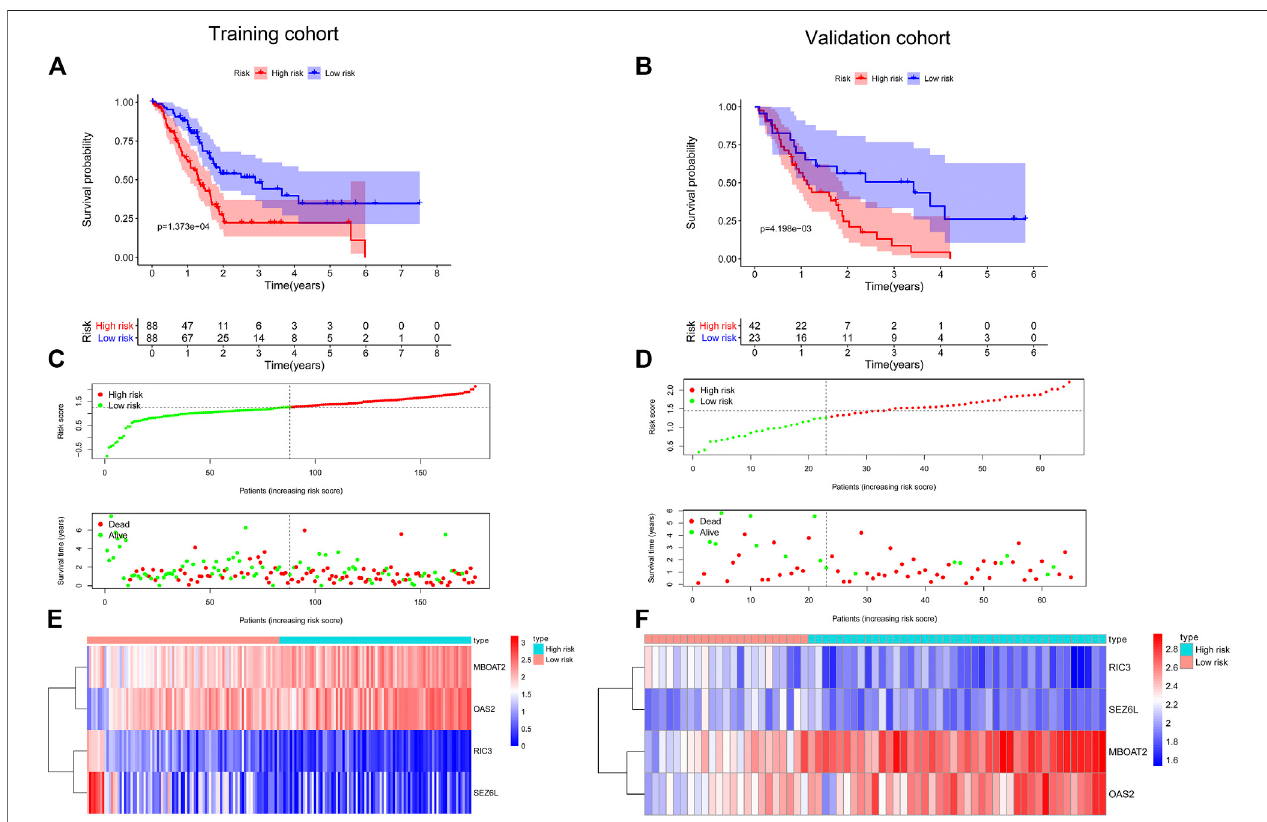
FIGURE6| EstablishmentandvalidationofaprognosticmodelforPC.Kaplan – Meiersurvivalcurvesshowedthatthehigh-riskgrouphadshorterOSthanthelow- risk group in the training cohort (A) and the validation cohort (B) . The distribution of the survival status and time in different risk groups by the scatter plots in the training cohort (C) andthevalidationcohort (D) .HeatmapofthefourscreenedDNAmethylation-drivengeneexpressioninthehigh-andlow-riskgroupsfromthetrainingcohort (E) and the validation cohort (F) . PC, pancreatic cancer; OS, overall survival.